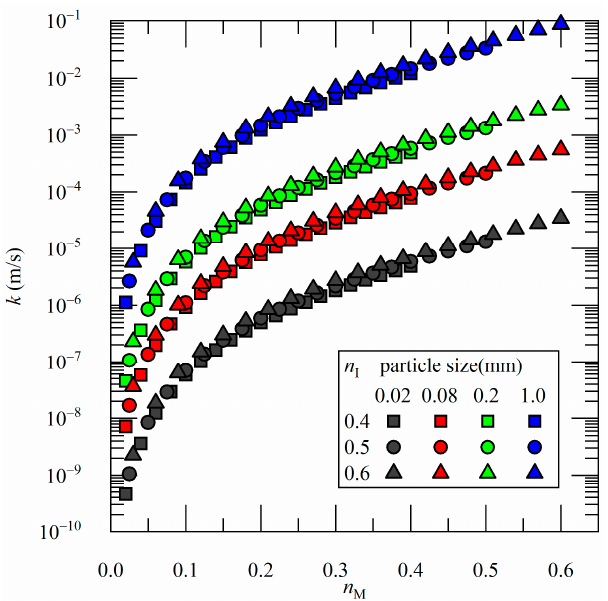
Figure 4. Relationship between hydraulic conductivity and the mobile porosity ( n f = 0.025). The final mobile porosity was then changed to 0.01 and 0.0025, respectively. Follow- ing the same steps as above, the data of the other 24 points correspond to n f = 0.01, and n f = 0.0025, as shown in Figure 5, could be